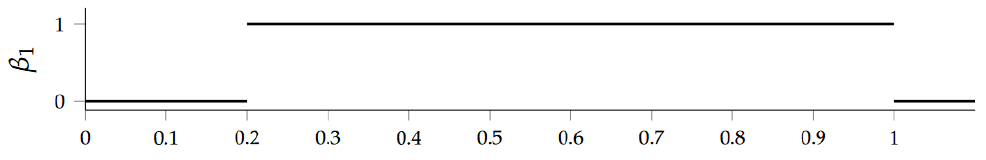
Figure 6. β 1 barcode of the circle dataset of Figure 5. Figure from